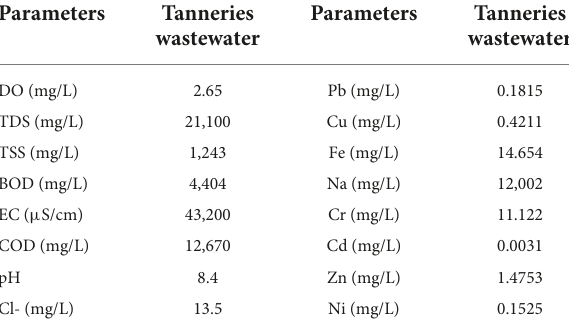
TABLE 1 Characterization of tannery wastewater used in the